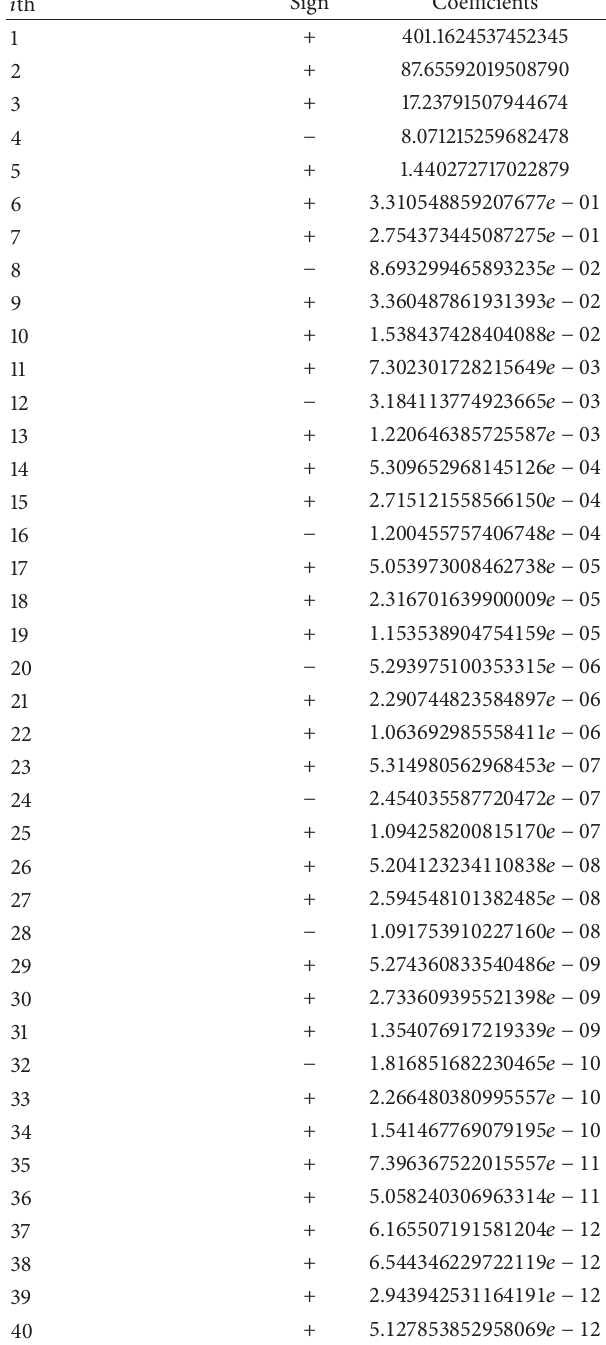
Table 3: Computed coefficients with the proposed enriched meshfree